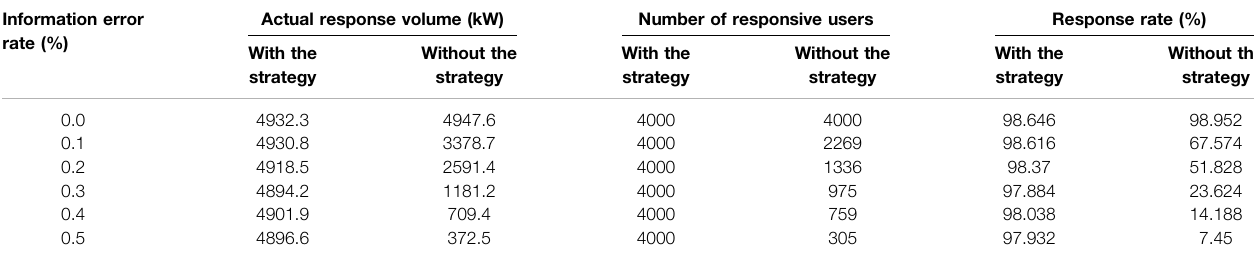
TABLE 5 | Implementation results of different information error rates in Case 2. Information error rate